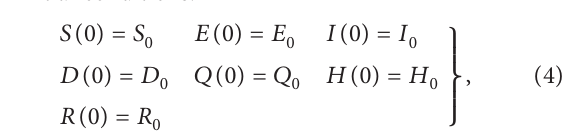
Figure 1: Model flow